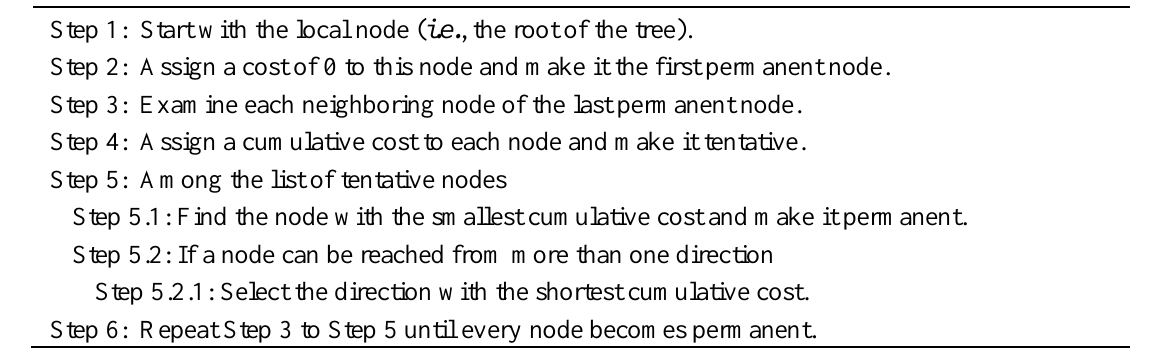
Table A3. Dijkstra routing algorithm